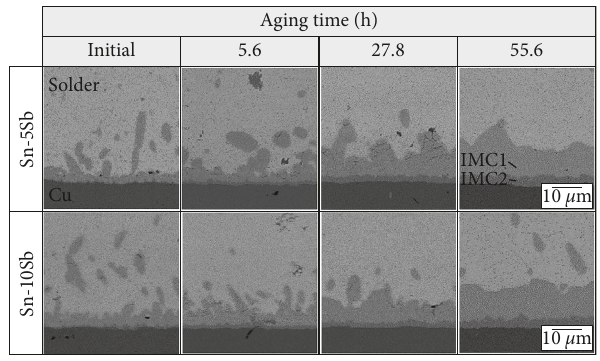
Figure 11: Back-scattered electron images of cross sections of IMC layers formed in interfaces of Sn-Sb/Cu joints after heat aging test at 200 ° C.